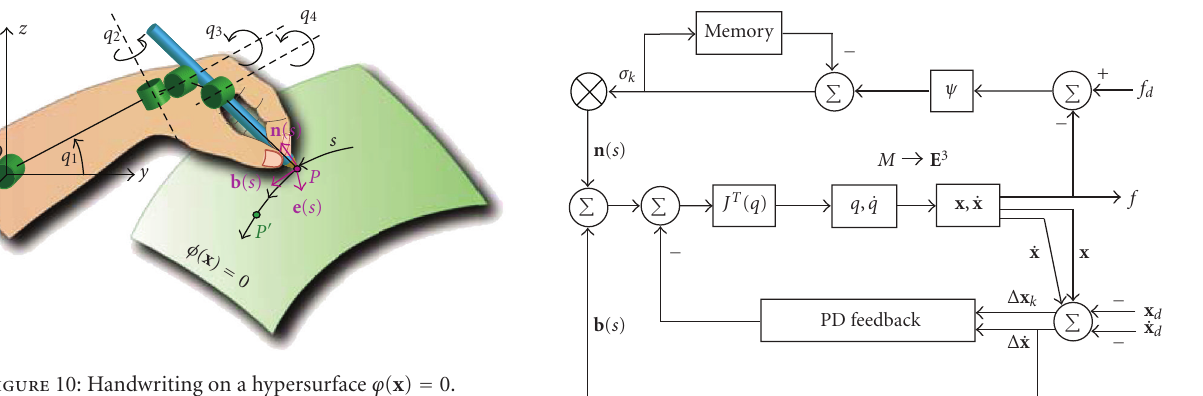
Figure 10: Handwriting on a hypersurface ϕ ( x ) = 0.